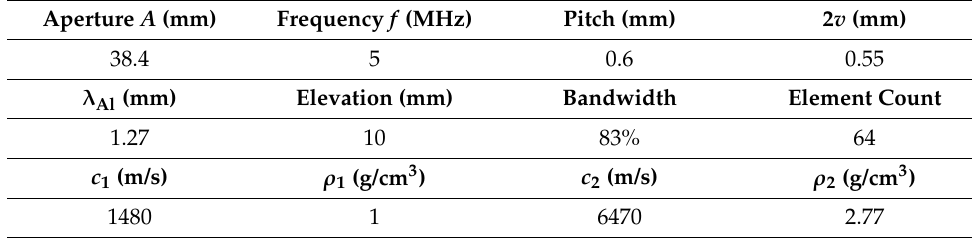
Table 2. Probe and material parameters.